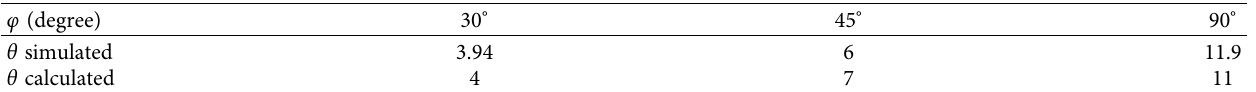
Figure 11: Normalized E patterns for various phase shifts and beam rotating. Table 2: Simulated and calculated “ θ ”